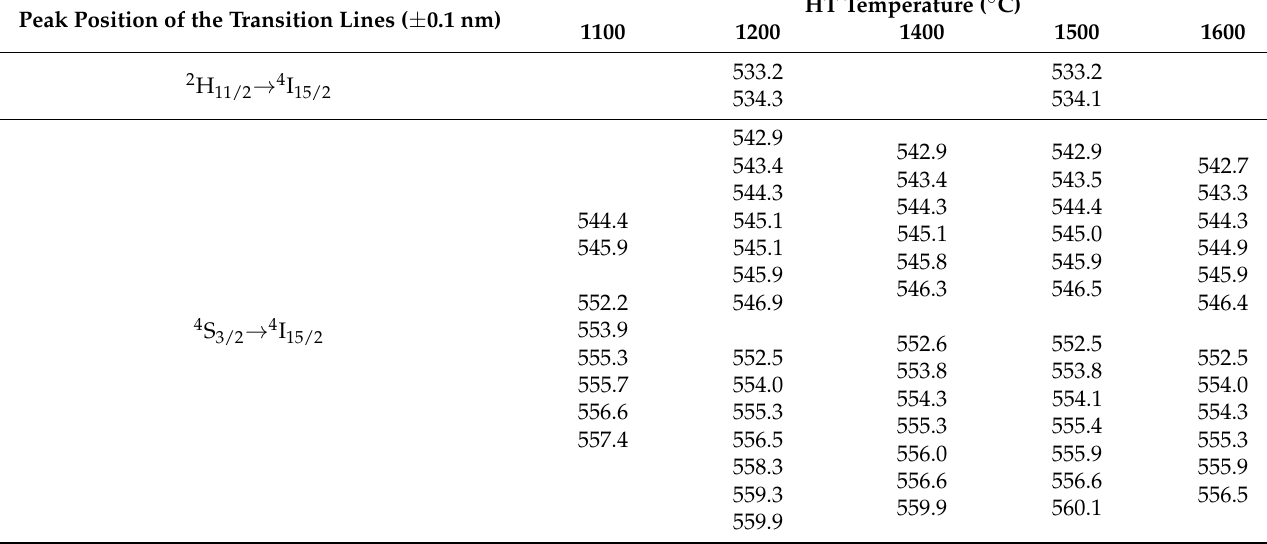
Table 1. Assignments and peak position of the Er 3+ intrashell lines for the ErNbO 4 samples heat-treated at temperatures >900 ◦ C. Peak Position of the Transition Lines ( ± 0.1